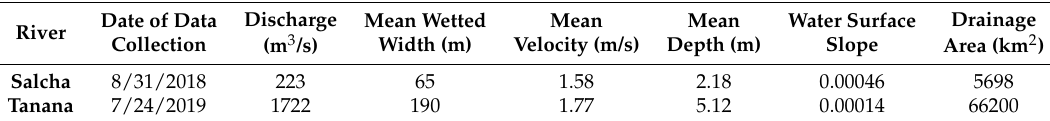
Figure 1. ( a ) Location of the Salcha and Tanana Rivers within the state of Alaska, near the city of Fairbanks. ( b ) Example image from the Salcha River. ( c ) Example video frame from the Tanana River. The red arrows in ( b , c ) represent depth-averaged velocity vectors measured directly in the field with an acoustic Doppler current profiler (ADCP). Table 1. Basic hydraulic characteristics of the Salcha and Tanana Rivers at the time of data